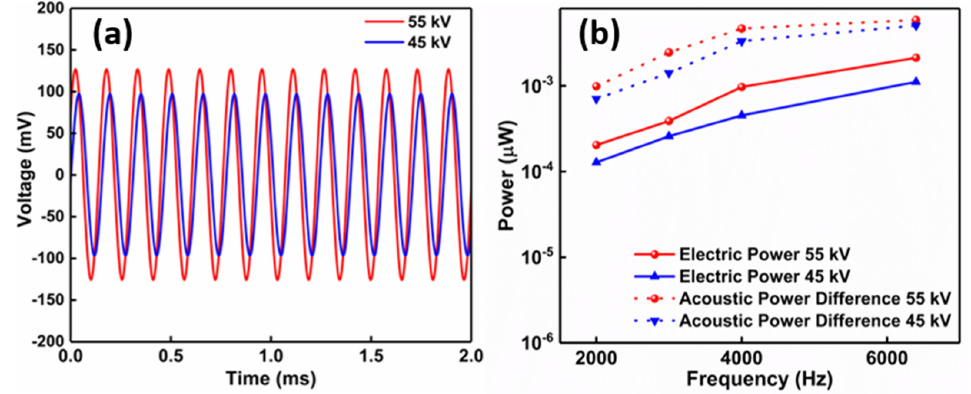
Figure 3. ( a ) Voltage outputs from the PE foam samples poled at different poling voltages under excitation of 85 dB at 6400 Hz, and ( b ) electric power outputs and difference of acoustic power in the two samples poled at different poling voltages under excitation of 85 dB at various frequency